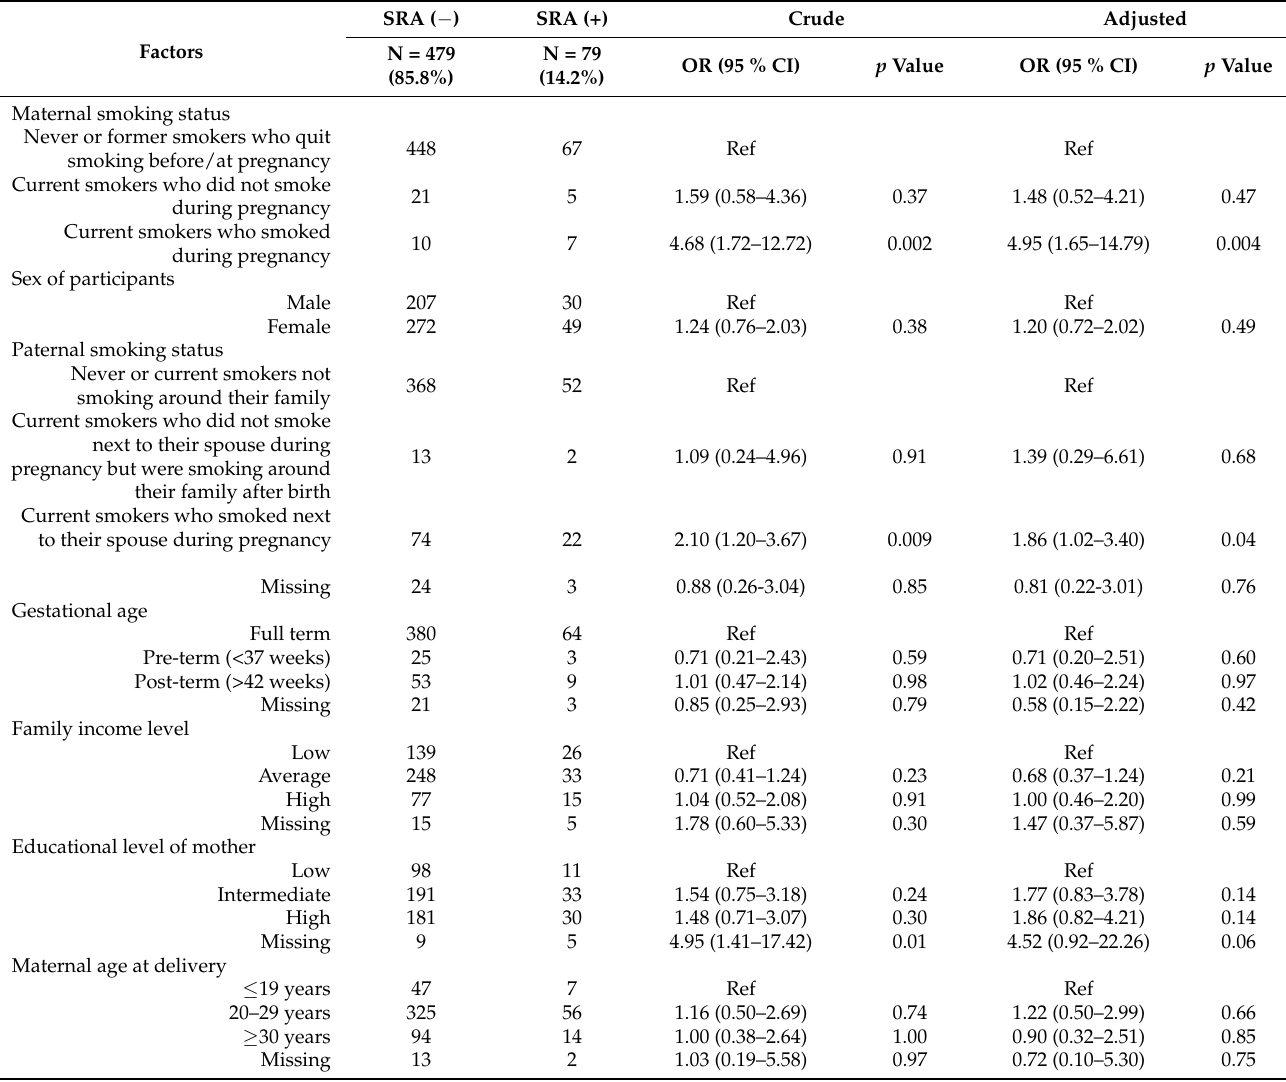
Table 4. Unadjusted and adjusted odds ratios for